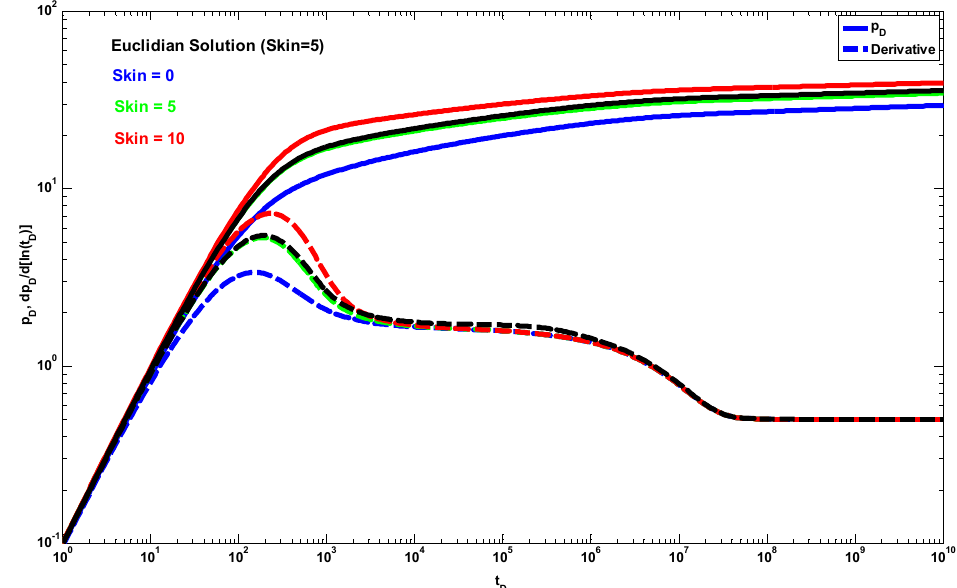
Figure 4. Euclidean case: z wD = 0, h D = 10,000, h pD = 0.3, C D = 10, ε = 1, d fr = 2, θ r = 0, d fz = 1, θ z = 0.